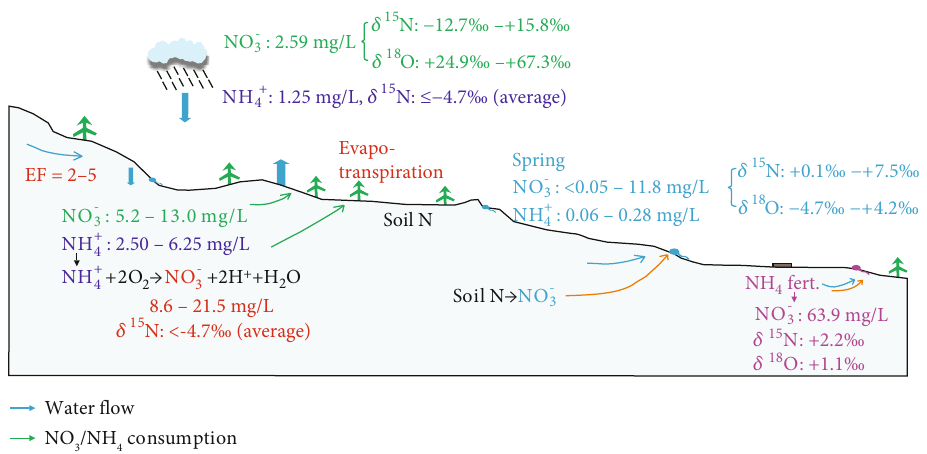
Figure 8: Conceptual model of the nitrogen cycle in the study area. Note: FE=enrichment